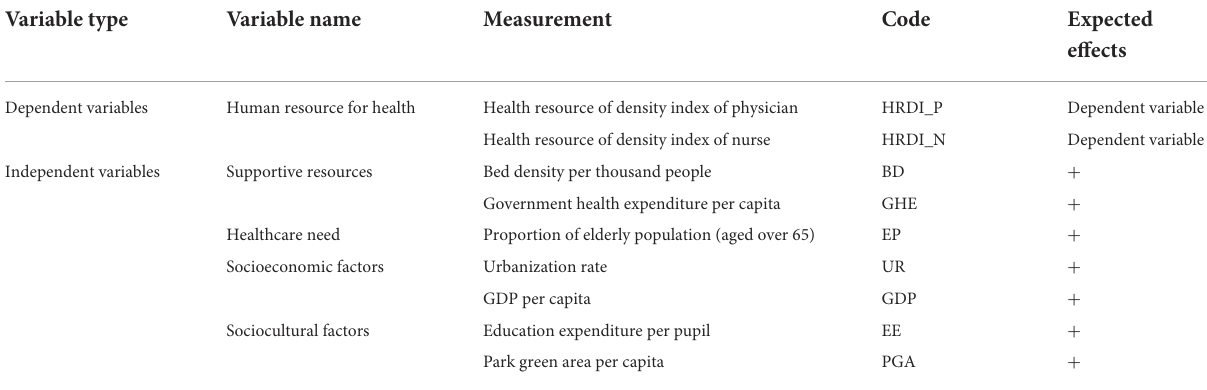
TABLE 1 Dependent and independent variables in this